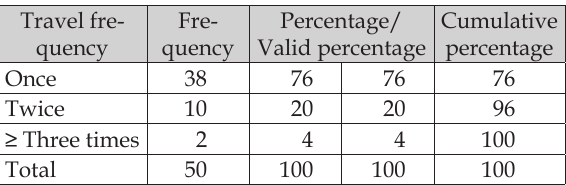
Table 5. Participants travel frequency to Iran.